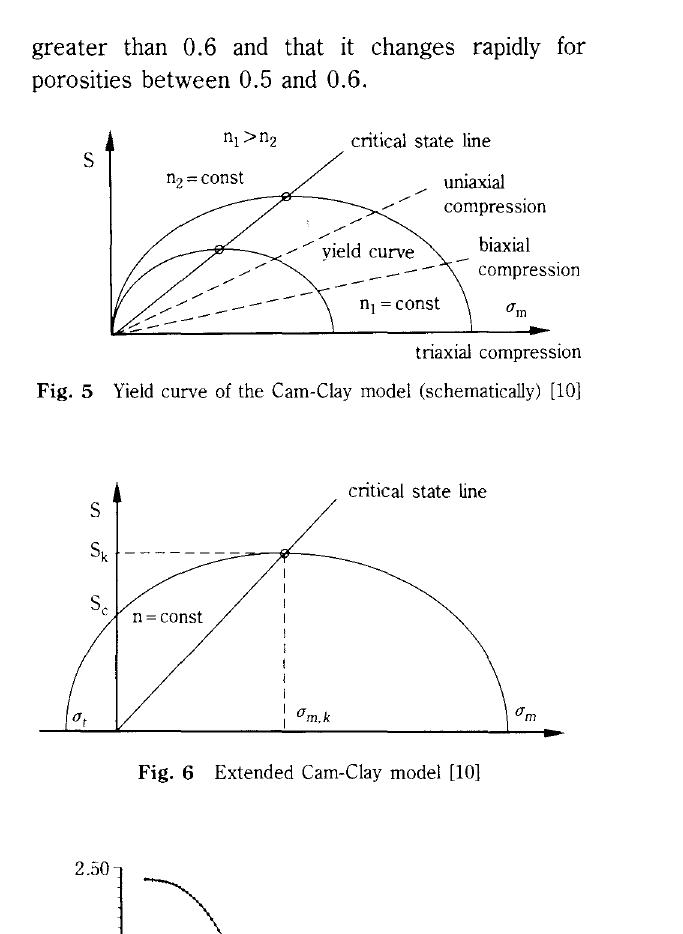
Fig. 6 Extended Cam-Clay model [10]